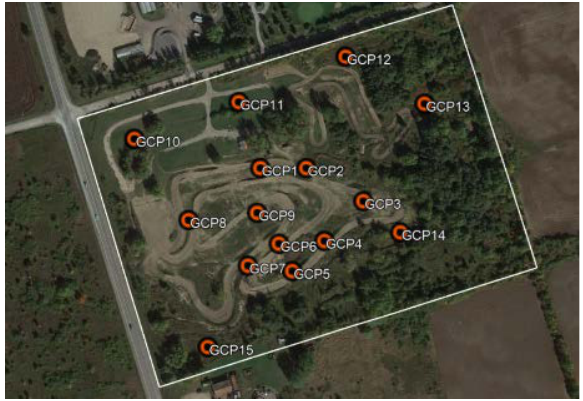
Figure 4: Applanix Test Field Showing GCP Layout The two flights were flown at a height above ground of approximately 100 meters, producing a GSD of approximately 4 cm in the imagery.